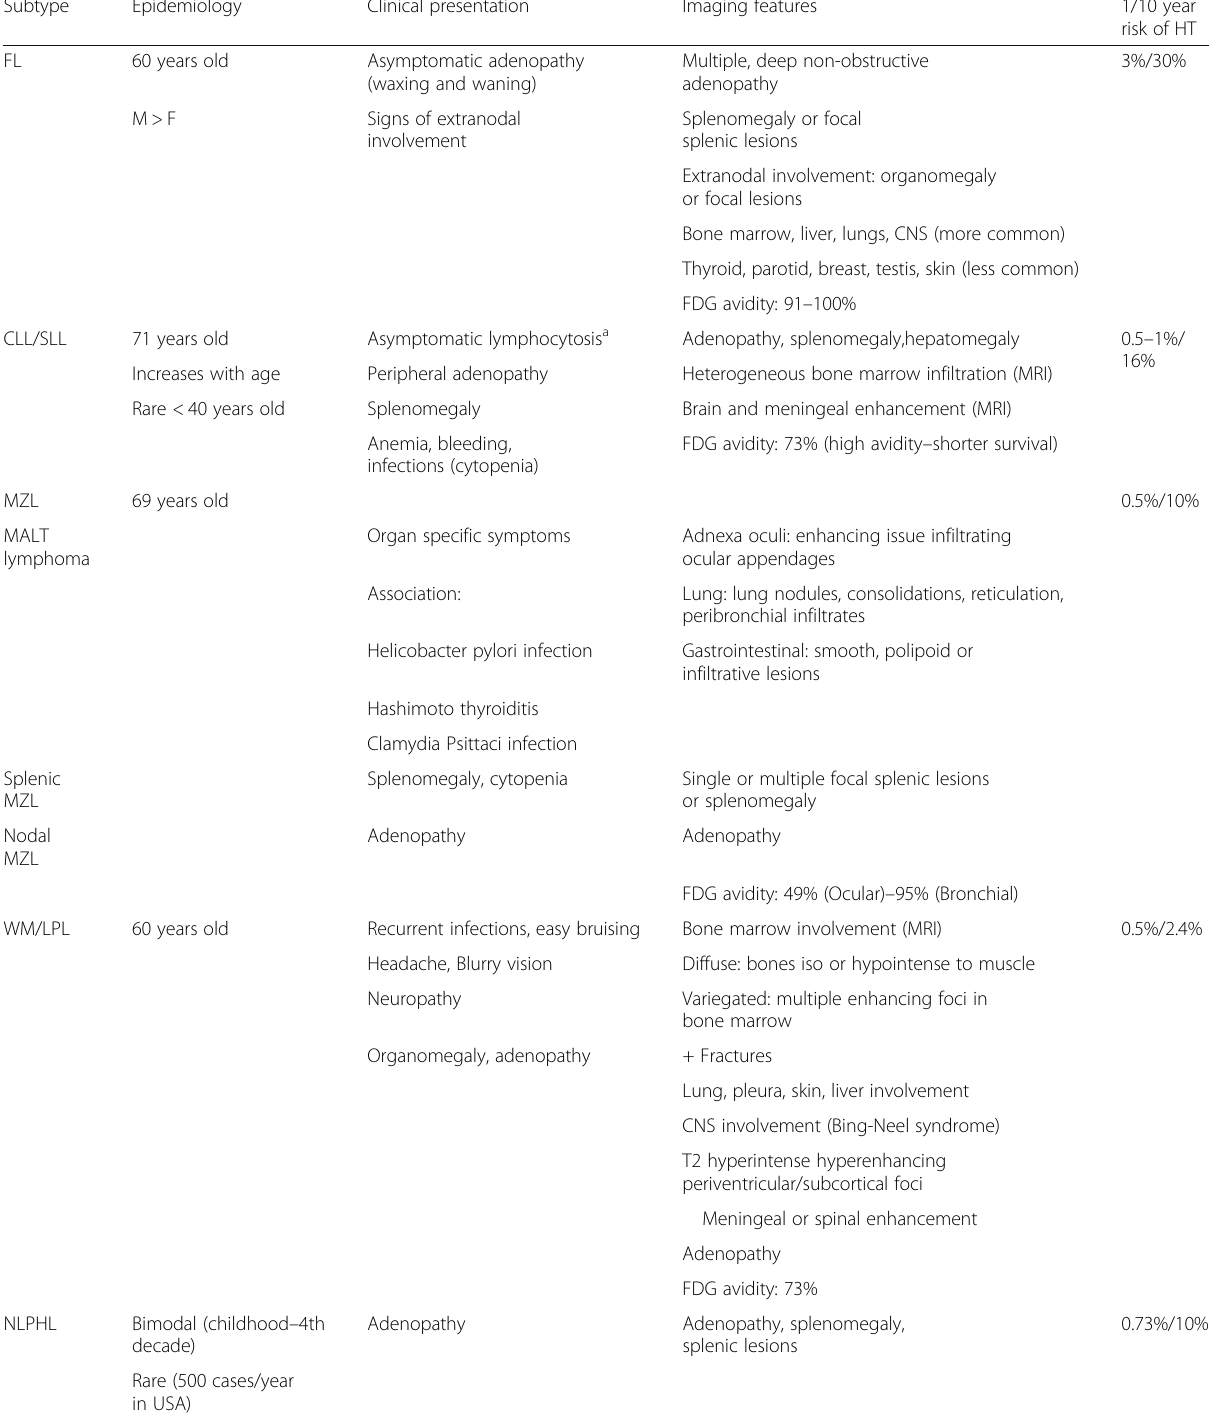
Table 1 Clinical and imaging characteristics of B cell indolent lymphomas undergoing histologic